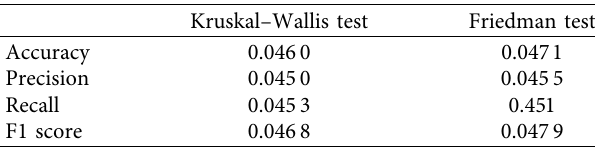
Table 5: Performance comparison of the classification algorithms using the Kruskal–Wallis and Friedman